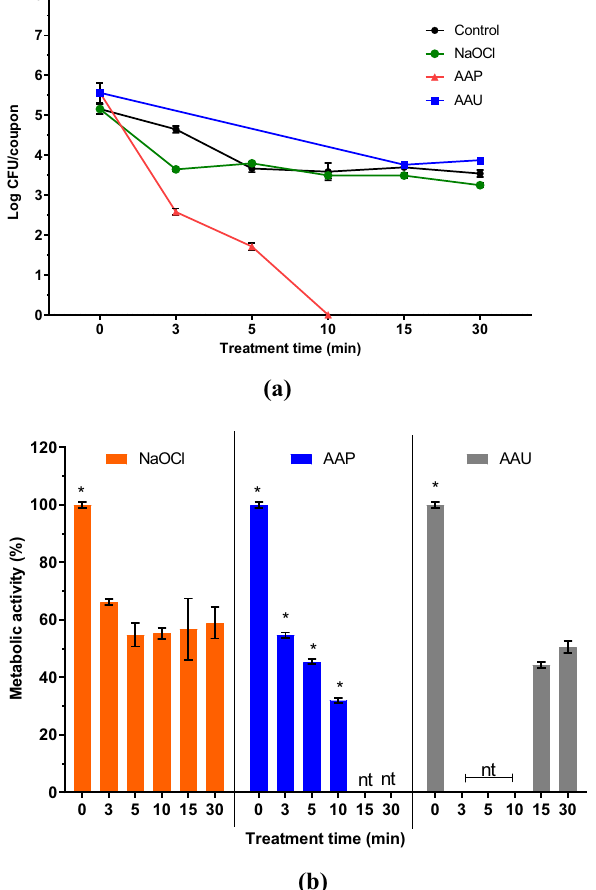
Figure 7. Effects of sodium hypochlorite (NaOCl; 200 ppm), atmospheric air plasma and airborne acoustic ultrasound treatments on 96 h E. coli biofilms—effect on ( a ) culturability (Log CFU/coupon) and ( b ) metabolic activity (%). Error bars show the standard deviation (n = 4). nt = not treated. The asterisk mark indicates significance difference between different treatments (p ≤ 0.05) analysed by one-way ANOVA and Tukey multiple comparison post hoc test. Graph was generated using GraphPad Prism version 5.0 (GraphPad Software, San Diego, California USA, http://www.graph